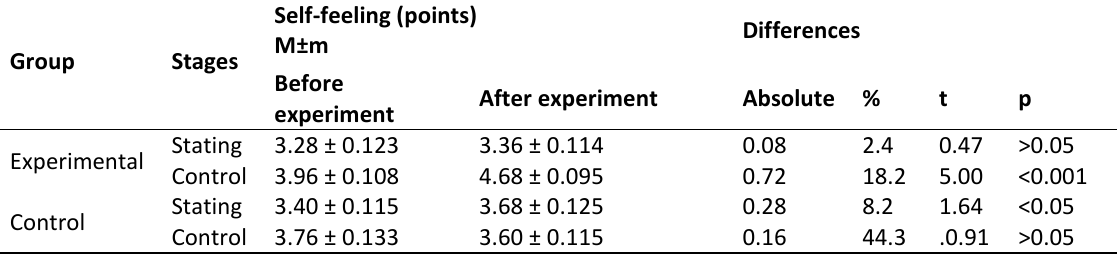
Table 2. Indicators of students’ self-feeling Group Stages